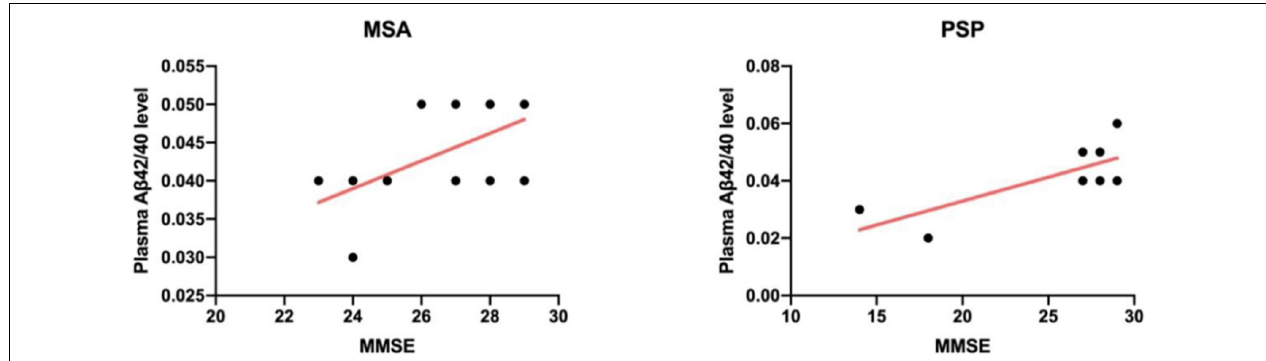
FIGURE 3 | Scatter plot showing the relationship between plasma A β 42/40 level and MMSE scores in the MSA group (Left) and PSP group (Right) . Solid line indicates a correlation observed between A β 42/40 level and global cognitive status in patients with APD (MSA: r = 0.583, p = 0.03; PSP: r = 0.763, p = 0.03). MSA, multiple system atrophy; PSP, progressive supranuclear palsy; A β 42/40, β -amyloid 42/40; MMSE, Mini-Mental State Examination.